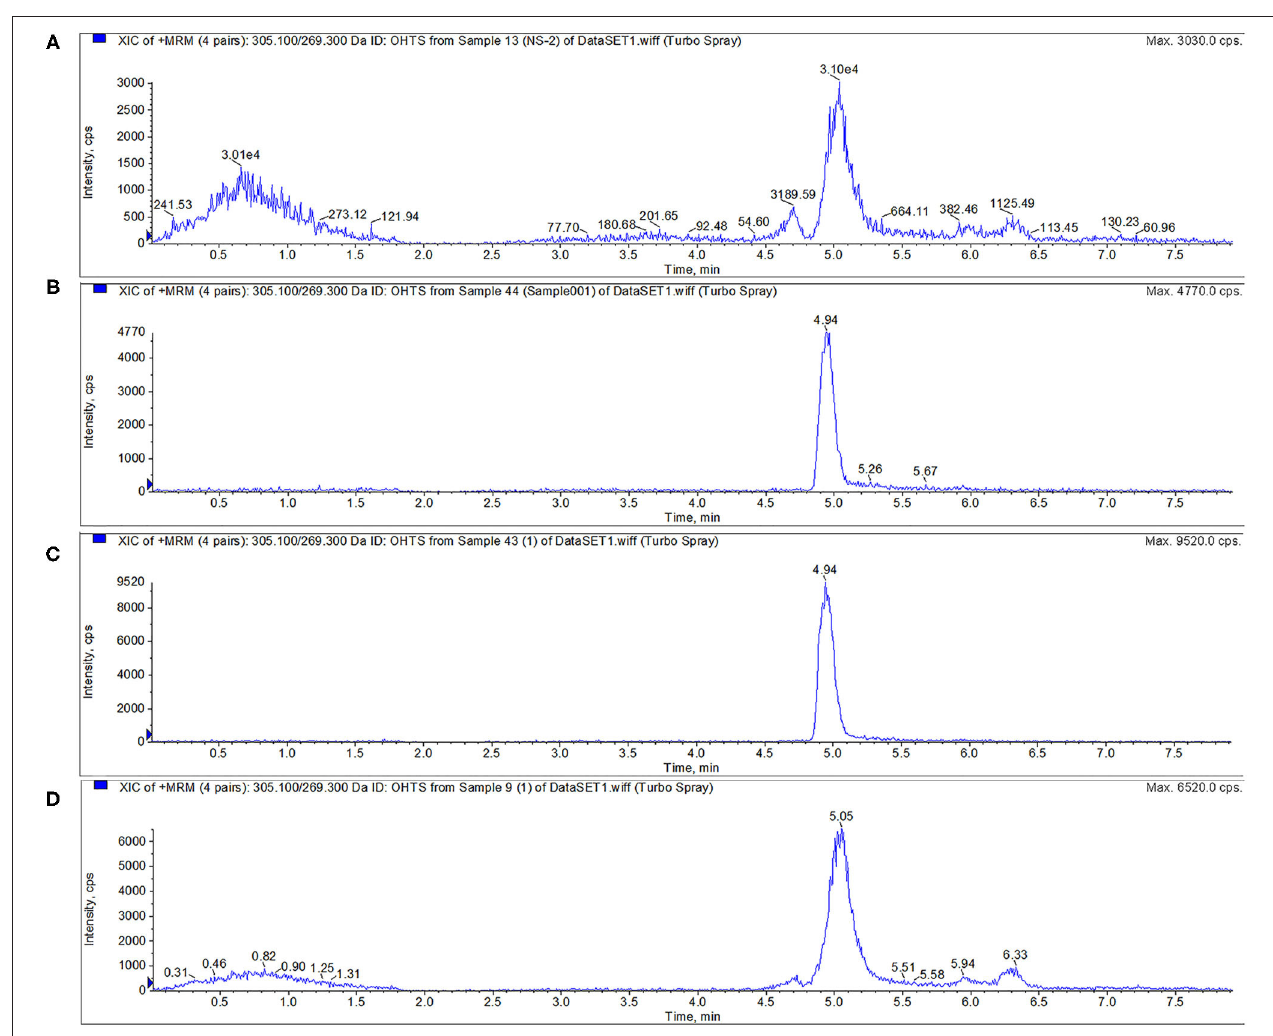
FIGURE 5 | Activity verification of CYP3A24 and mutant protein. The results (A–D) show that CYP3A24, R105A, R372A and R440A could metabolize TS into 6 β -OHTS. Note: (A–D) are the chromatograms of CYP3A24 (A) , R105A (B) , R372A (C) , and R440A (D) .